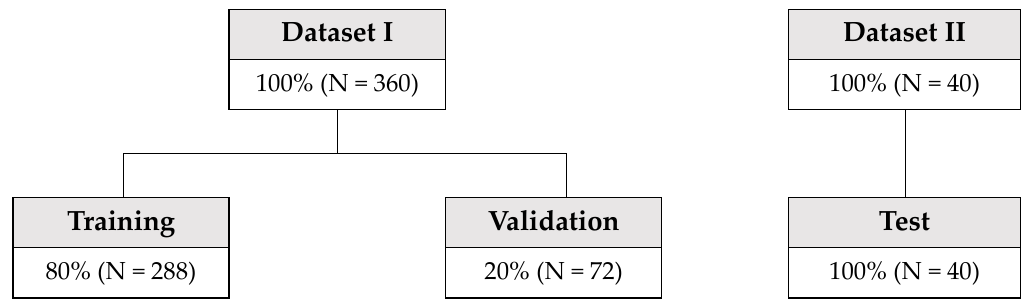
Figure 10. Data arrangement and split scheme for machine learning training/validation (Dataset I) and test (Dataset II).